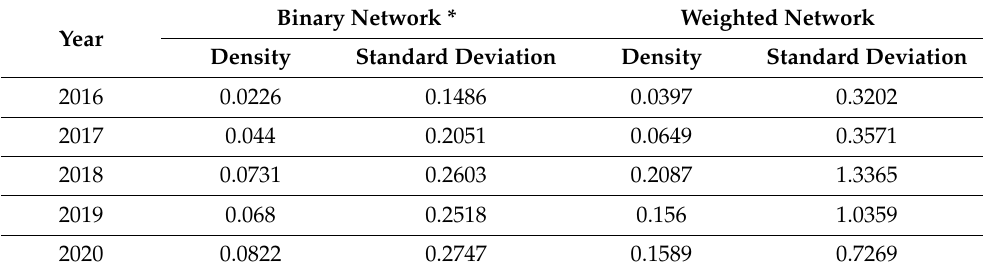
Table 5. The food safety risk transfer network density.